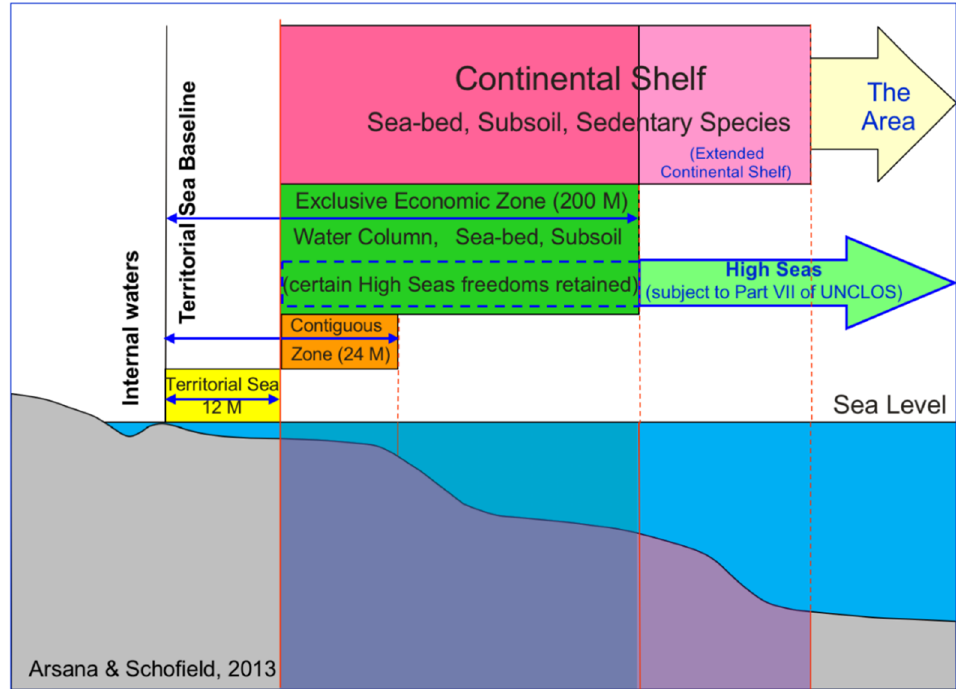
Figure 2. Baselines and maritime zones [4].